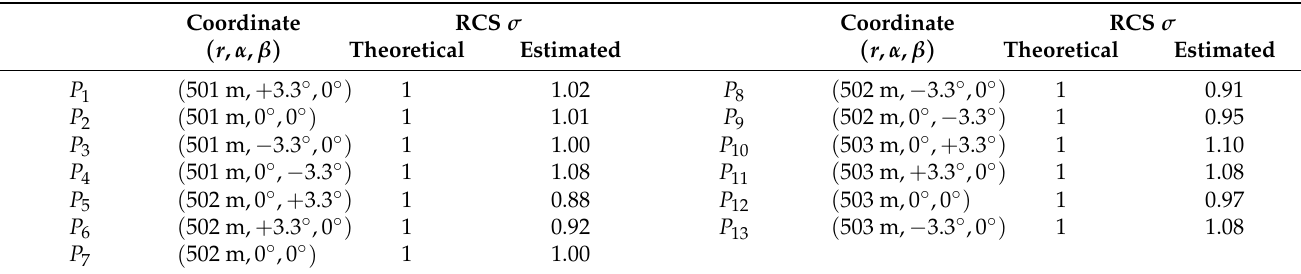
Table 5. Coordinates and estimated RCS of the scattering